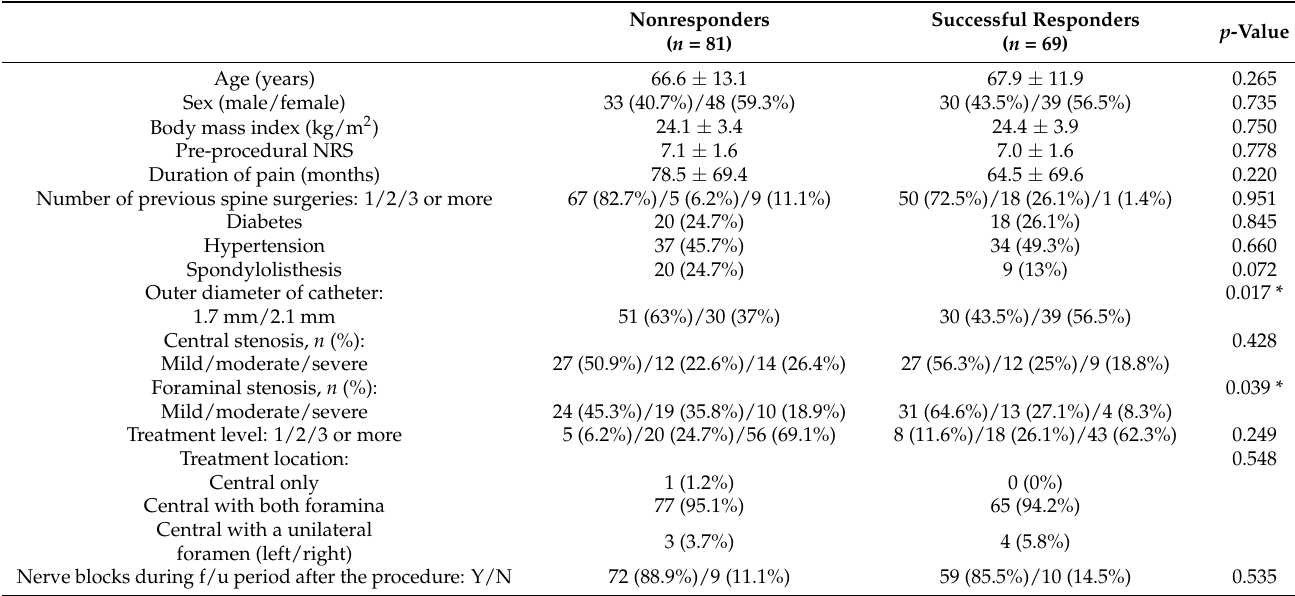
Table 3. Characteristics of nonresponders and responders at three months after adhesiolysis among patients with lumbar failed back surgery